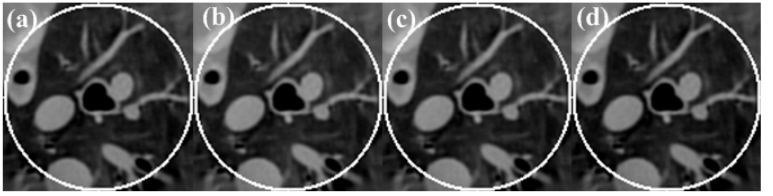
Figure 10. Reconstruction results with different DC:( a )DC = 2900; ( b ) DC = 3000; ( c ) DC = 3100; ( d ) DC = 3200.The display window is [ − 700 800]HU. ( d ) DC = 3200. The display window is [ − 700